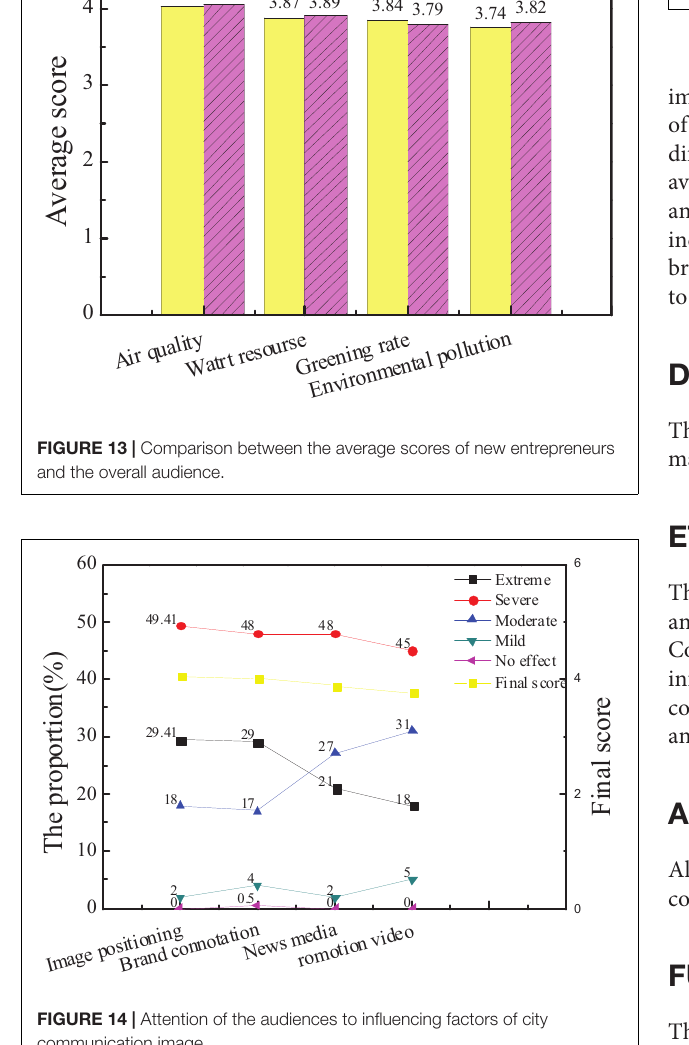
FIGURE 15 | Comparison between the average scores of new entrepreneurs and the overall